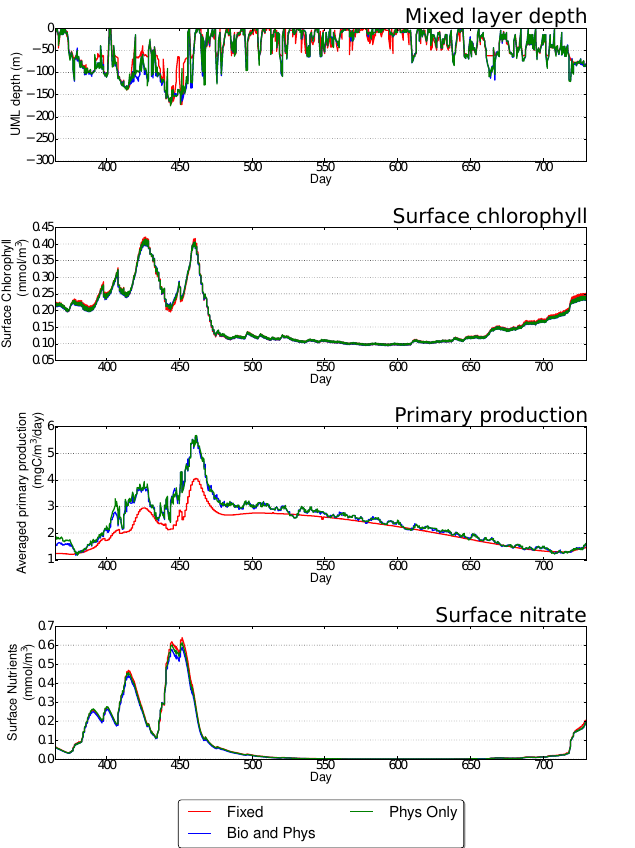
Fig. 14. Summary of results comparing different adaptivity metrics against measured data and the high-resolution (2.5m) fixed-mesh simulation for Station